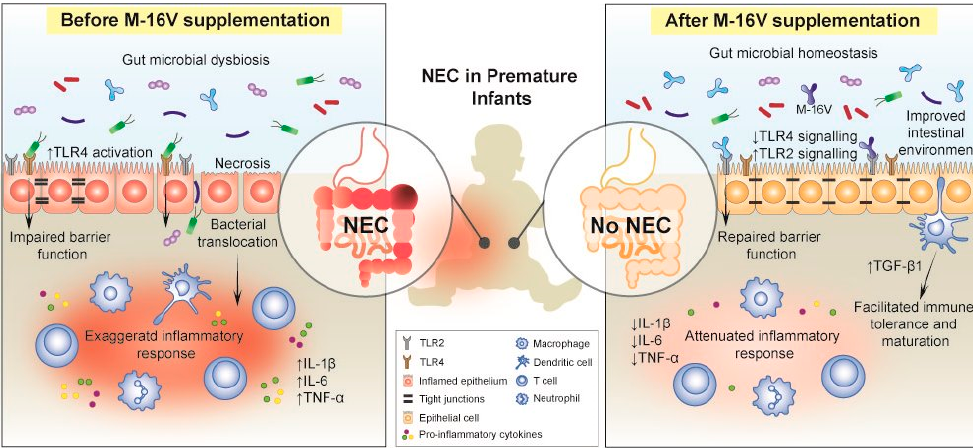
Figure 1. Administration of Bifidobacterium breve M-16V showed potential in reducing the risk of developing necrotising enterocolitis (NEC) in premature infants. M-16V stimulates the colonisation of bifidobacteria and could potentially improve the intestinal environment and gut barrier function. Additional mechanistic studies revealed that M-16V may assist the development of mucosal immunity through up-regulation of transforming growth factor-beta (TGF- β ) signalling in premature infants and attenuate inflammatory reactions by modulating the expressions of toll-like receptor 2 (TLR2) and TLR4. IL-1 β , interleukin-1 β ; IL-6, interleukin-6; TNF- α , tumour necrosis factor alpha; ↑ , increased; ↓ , decreased.